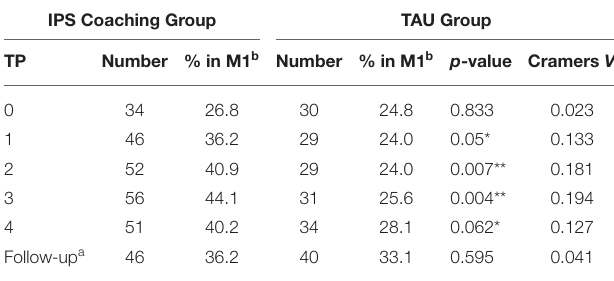
TABLE 6 | Employment rate across the time points ( n = 248). IPS Coaching